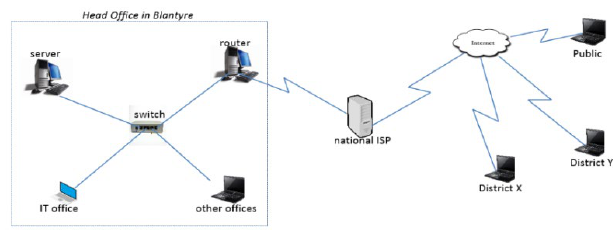
Figure 1. Implementation of IS for Organisation